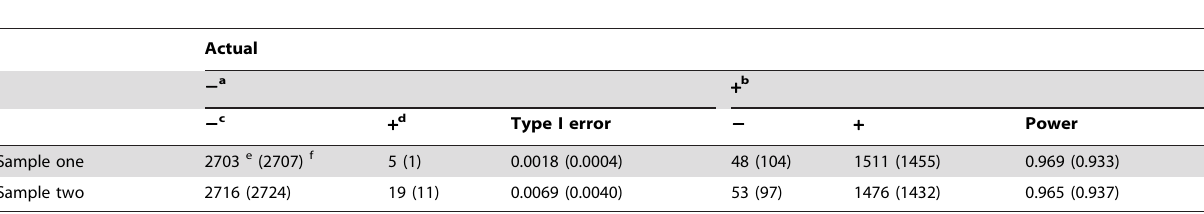
Table 5. Simulation result: Comparison of One-Step Model and MC_DIST as tools to distinguish true pairs from false pairs.